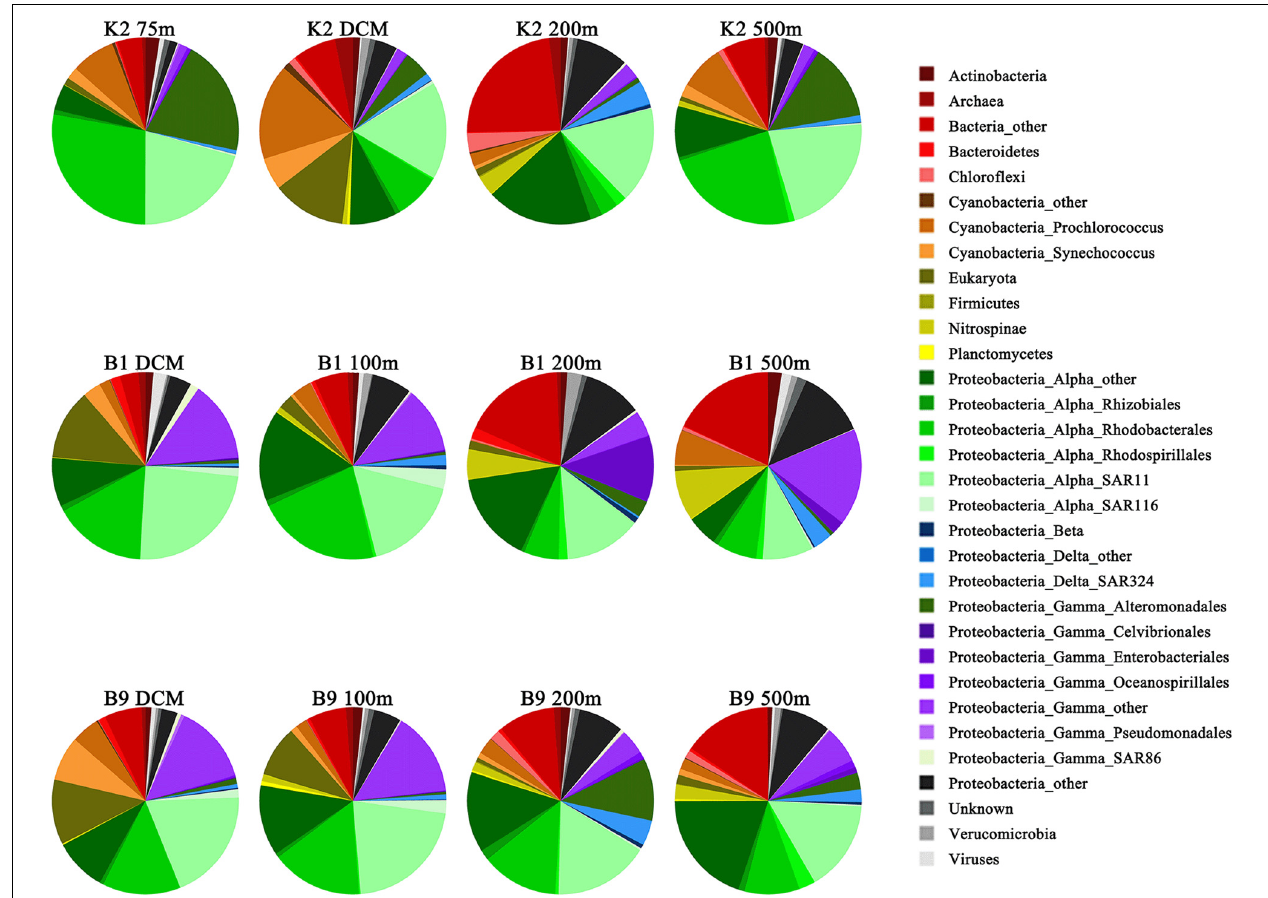
FIGURE 4 | Taxonomic composition of prokaryote communities identified in the transport proteins. Prokaryotic taxa with > 1% relative abundance on average are displayed and named in the format,